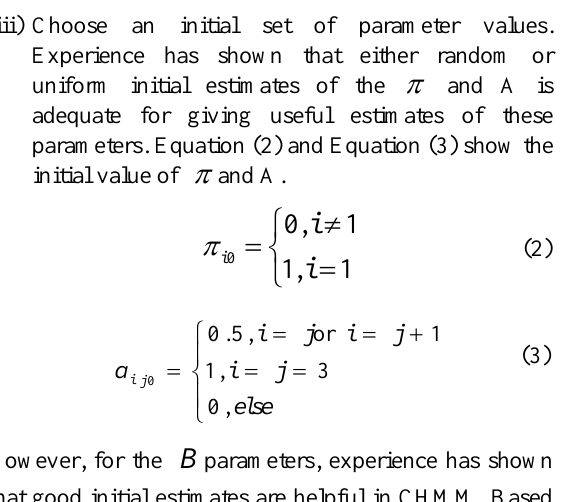
Fig. 5. Data extraction method (take steering angel and steering angel velocity for